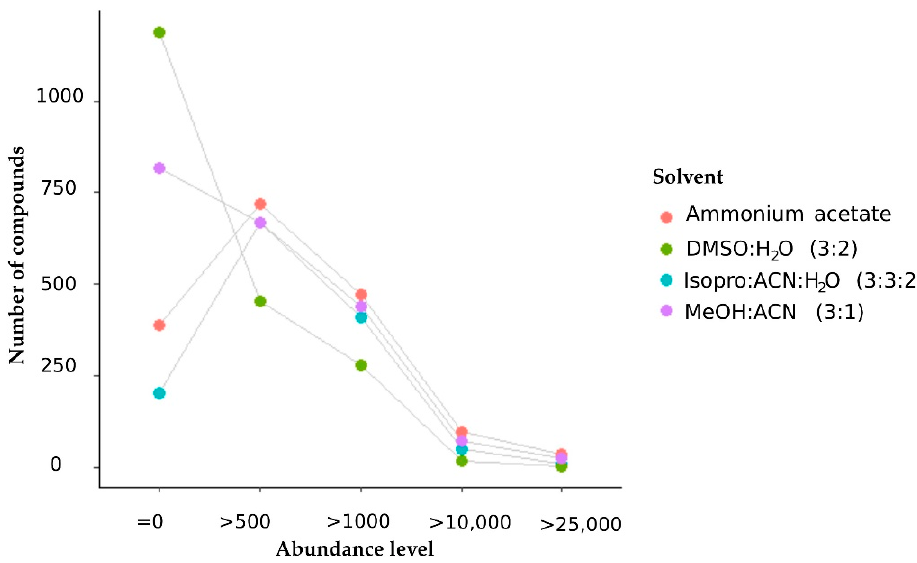
Figure 6. Dotted lines represent the number of features detected and their abundances across the four different extraction solvents. Each dot represents a solvent type.